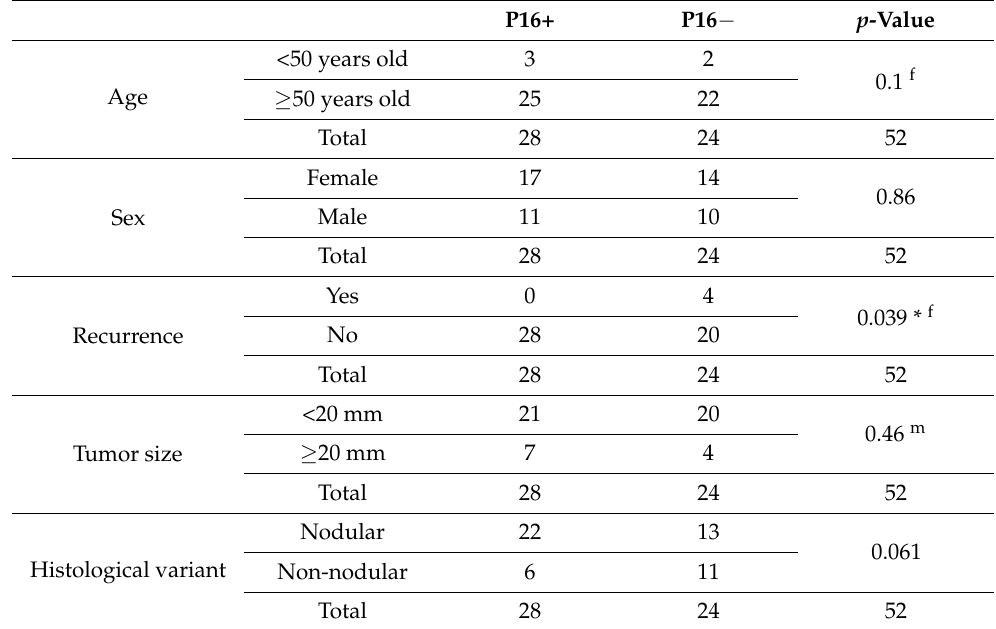
Table 2. P16 status in correlation to other clinico-pathological